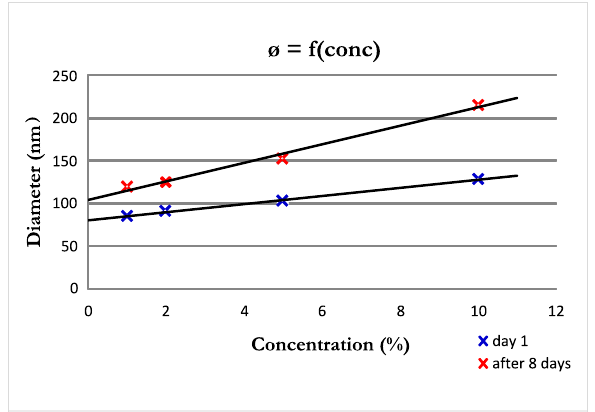
Figure 2: The dependency between the nanoparticles’ diameter (formed by 3 in water) as a function of the concentration.